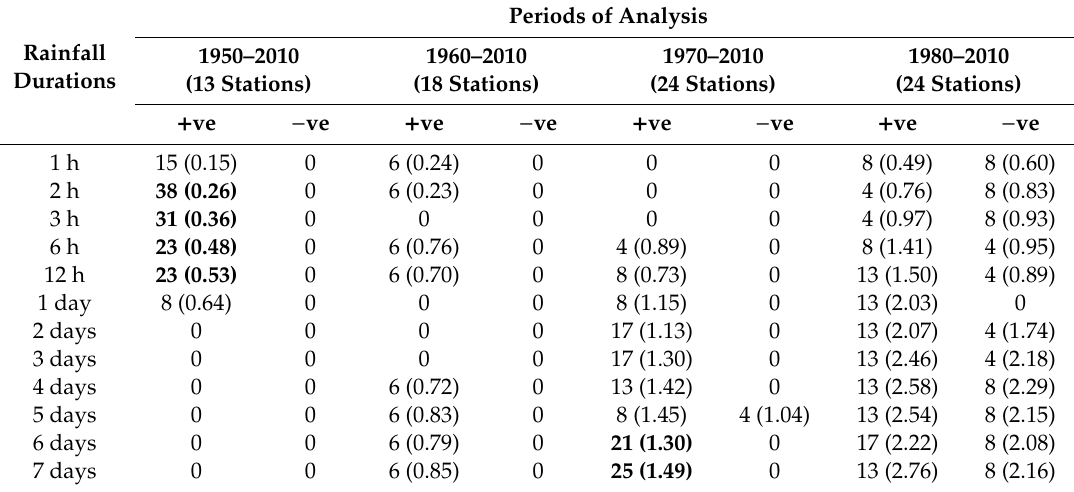
Table 2. Percentage (%) of stations with significant trends and the corresponding trend-slopes (in parentheses; mm / year) for the magnitude of annual maximum